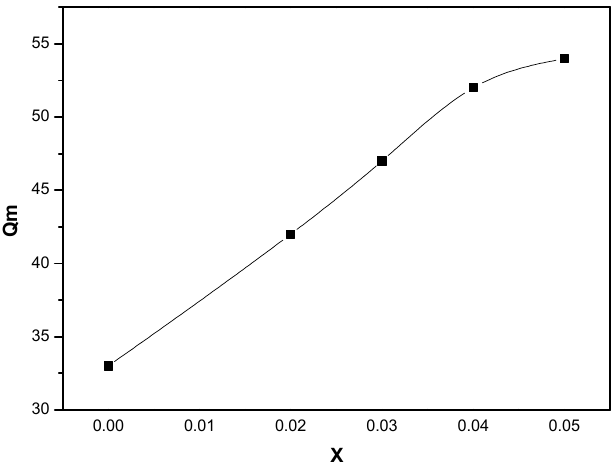
Figure 5. Mechanical quality factor (Qm) of specimens with x.